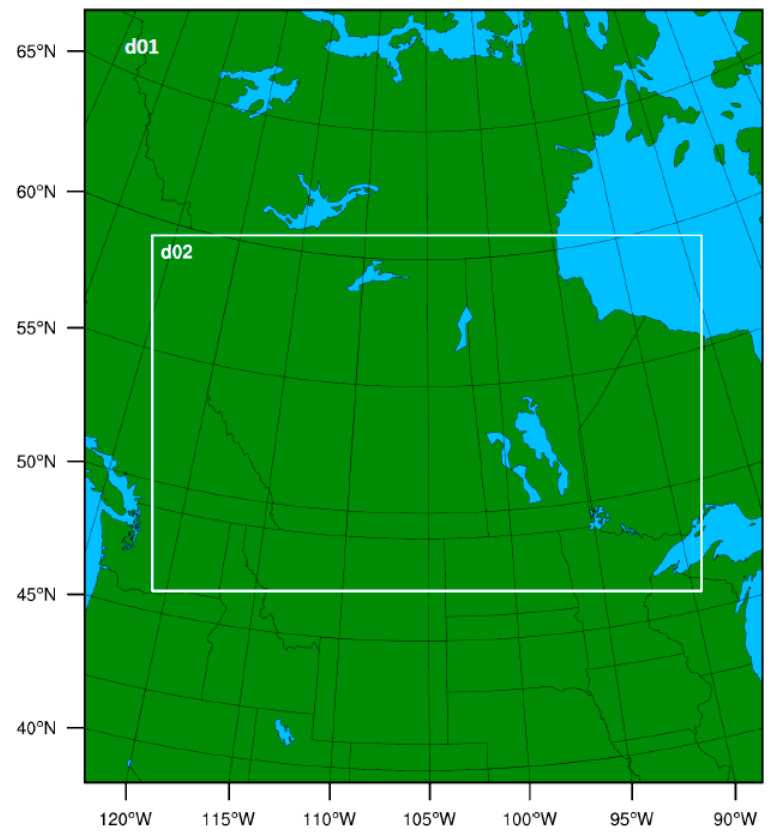
Figure 2. The mother domain (d01) at 30 km resolution and the nested domain (d02) with 10 km